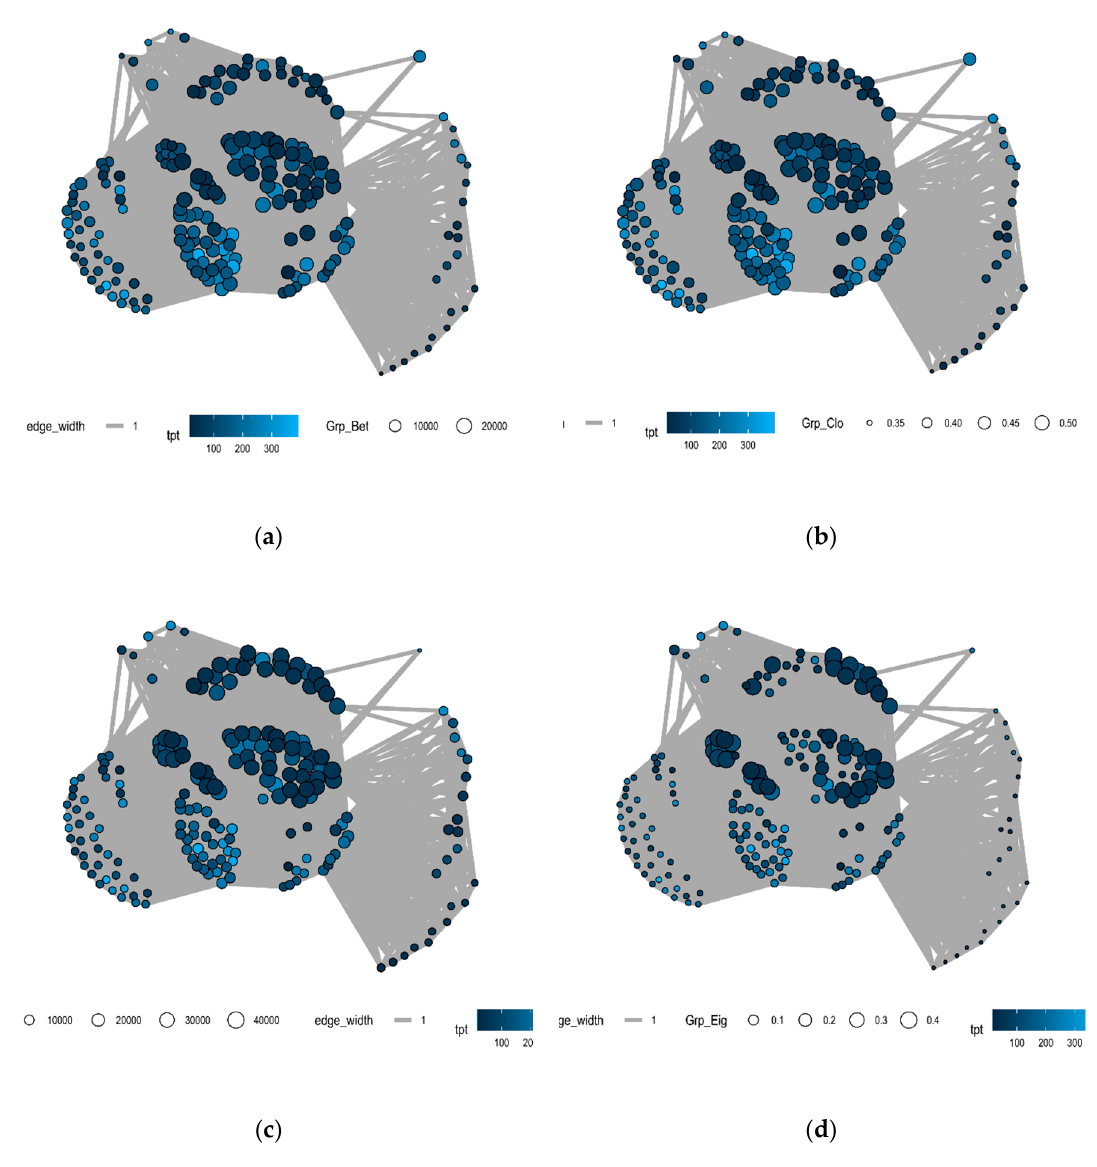
Figure 3. ( a ) BPIC 14 Group Between Centrality Graph; ( b ) BPIC 14 Group Closeness Centrality Graph; ( c ) BPIC 14 Group Degree Centrality Graph; ( d ) BPIC 14 Group Eigenvalue Centrality Graph.